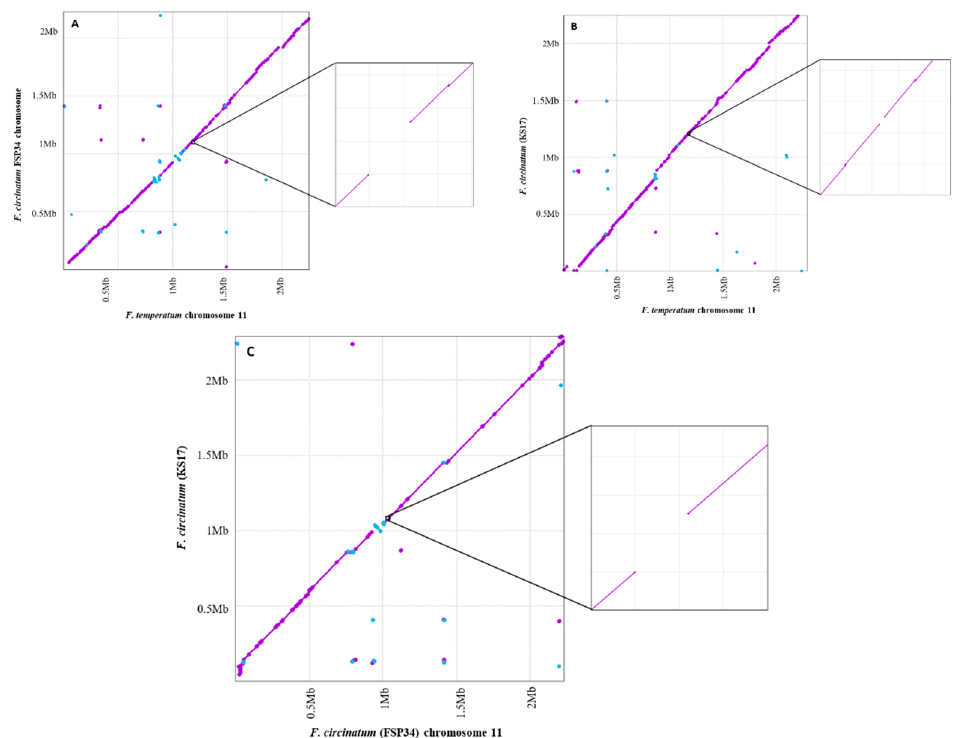
Figure 3. MUMmer-based comparisons of the region of chromosome 11 containing the identified QTL; ( A ) F. circinatum FSP34 versus F. temperatum , ( B ) F. circinatum KS17 versus F. temperatum , and ( C ) F. circinatum KS17 versus F. circinatum FSP34. In these dot plots, forward matches are indicated with purple dots, and reverse matches with blue dots. In all three cases, the insert shows a magnification of the target region, with a gap in synteny of around 7 Kbp.